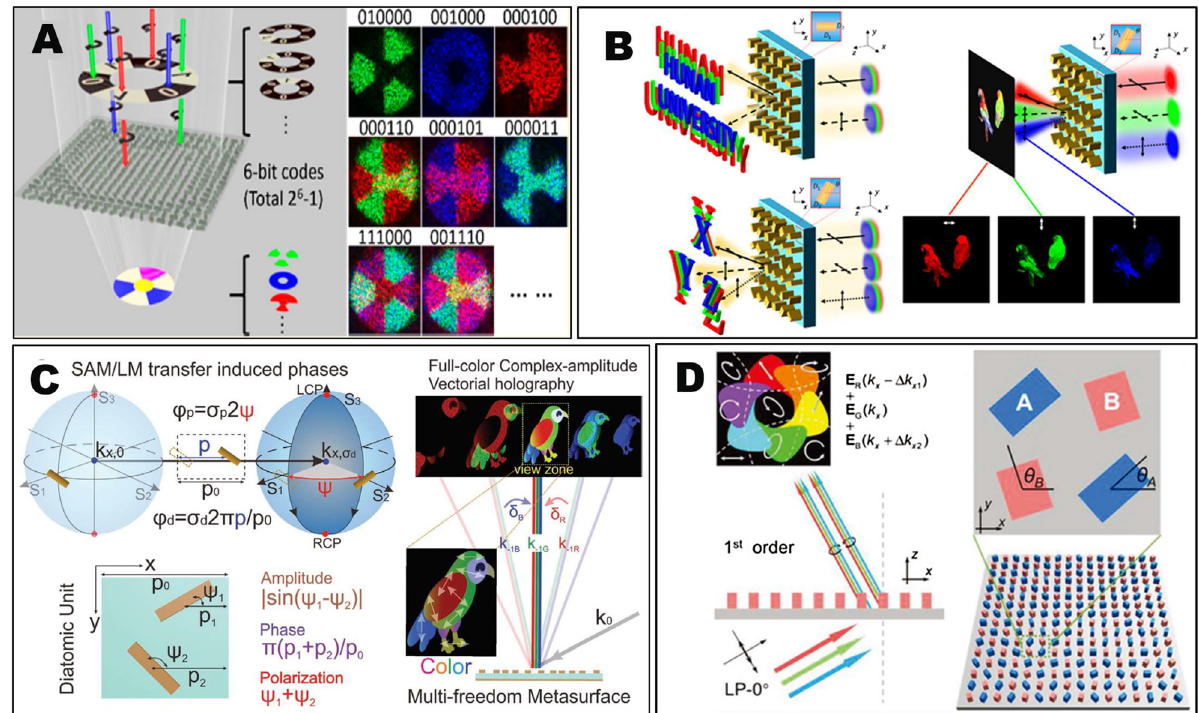
Figure 3: Full-colored metasurface vectorial